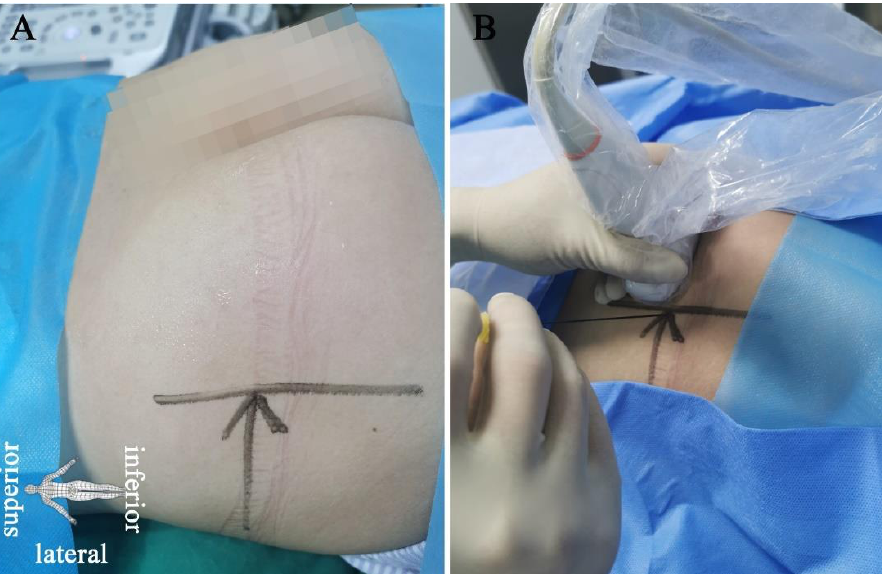
Figure 2. Positioning of the patient and the puncture with the ultrasound-guided improved pudendal NB/PRF technique. Patient with pudendal neuralgia in the prone position ( A ) and needle punctures in-plane into the lateral end of the low-frequency ultrasound transducer ( B